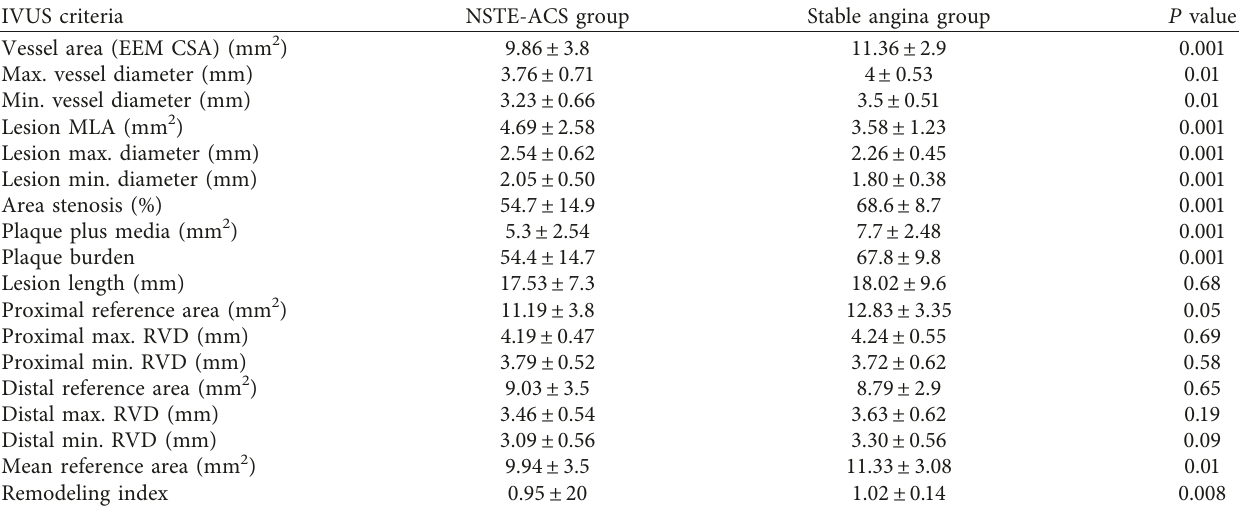
Table 3: Intravascular ultrasound criteria of SA and NSTE-ACS groups.